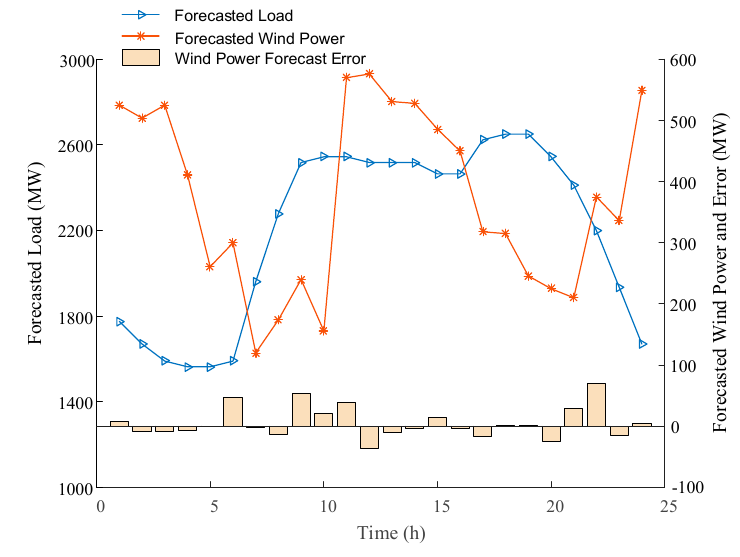
Figure 7. Wind power curve and forecast error.